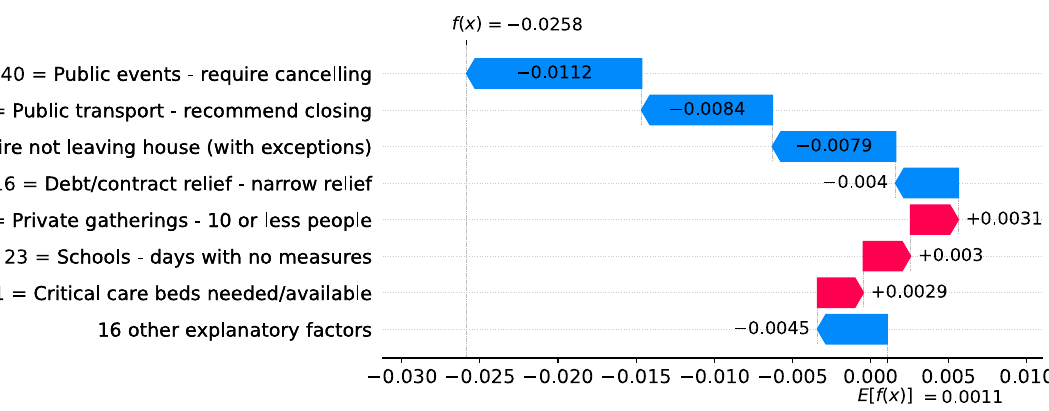
Fig 11. (Color online) waterfall plots for Italy. Factors driving acceleration on the 35 th day.